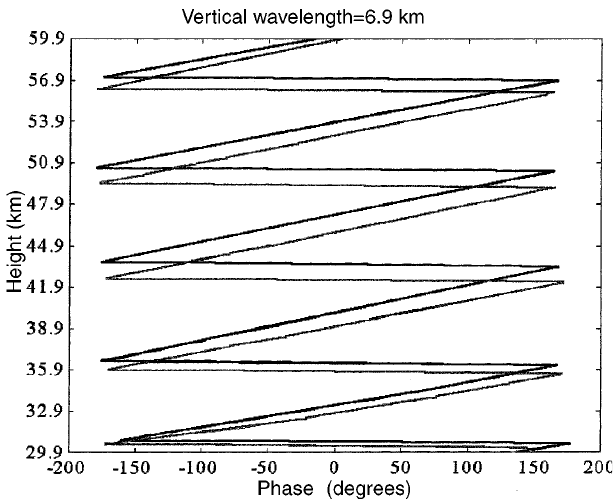
Fig. 5. Phase sections obtained by the application of the Morlet wavelet on file numbers 6 and 9 on June 21, 1994, ( black and gray curves respectively) are plotted for the dominant quasi-monochro- matic waves with 6.9 km vertical wavelengths. A clear downward phase progression is